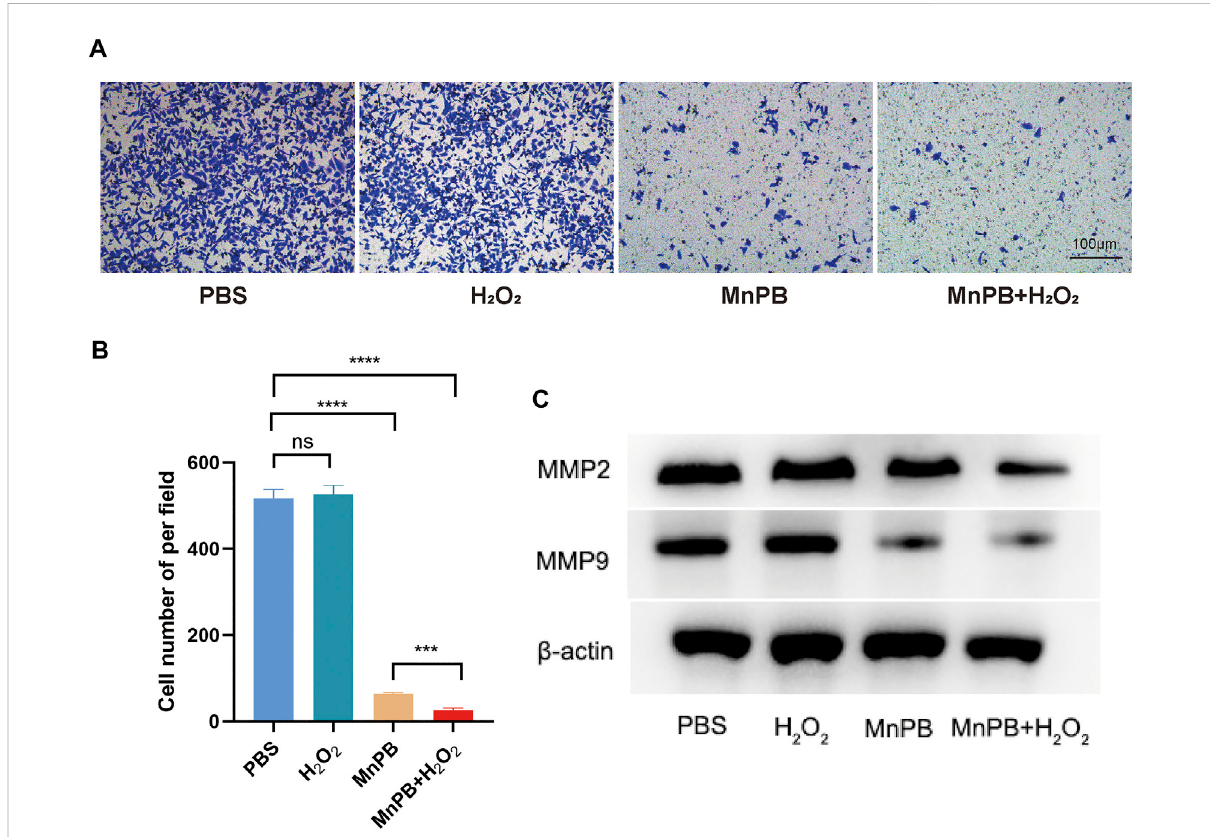
The MnPB NPsinhibit themigrationof PANC-1cells. (A) Tanswellassay of PANC-1cells after MnPB NPstreatmentfor 48hours. (B) The statistic analysis of transwell migration experiments. (C) The expression of MMP2 and MMP9 in four groups. * p < 0.05; ** p < 0.01; *** p < 0.001; **** p < 0.0001; ns: no signi fi